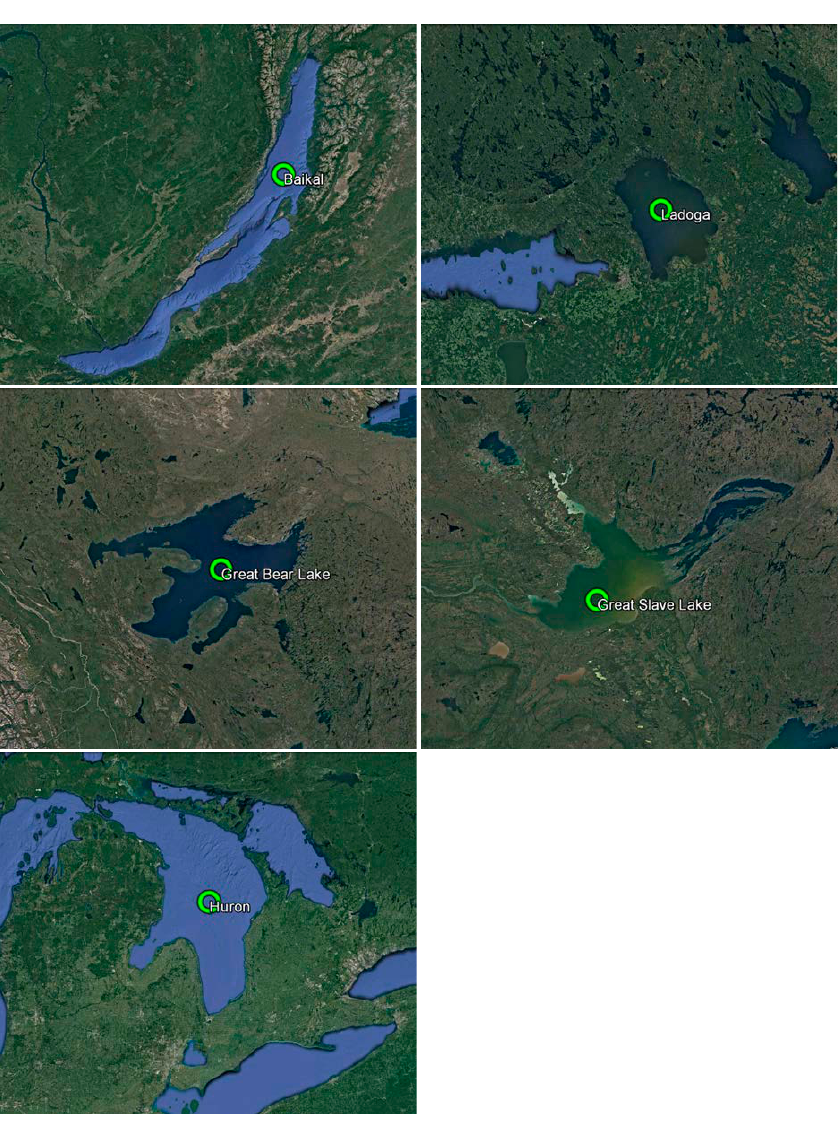
Figure 1. Maps of Baikal, Ladoga, GBL, GSL, and Huron. Green circles mark the SMOS L1C grid cells examined in the